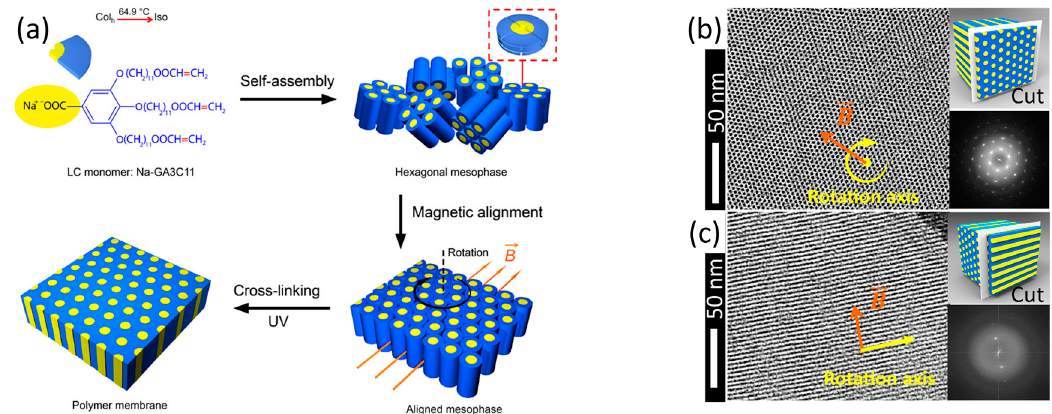
Figure 7 . The alignment of hexagonal ordered liquid crystals in a magnetic field. ( a ) Schematic representation of the alignment procedure; ( b , c ) Transmission electron microscopy images of the aligned material microtomed along ( b ) and perpendicular ( c ) to the columns. Adapted from [43], under ACS Author Choice License.